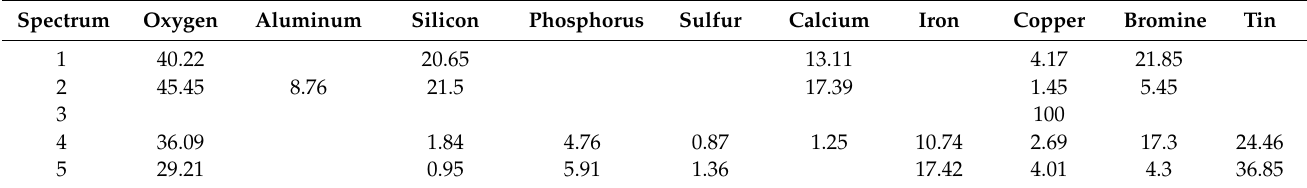
Figure 13. Micrograph (BSE-SEM) of a leached PCB (“coarse” fraction). Table 3. EDS mapping of leached PCB (%) (“coarse” residue shown in Figure 13).